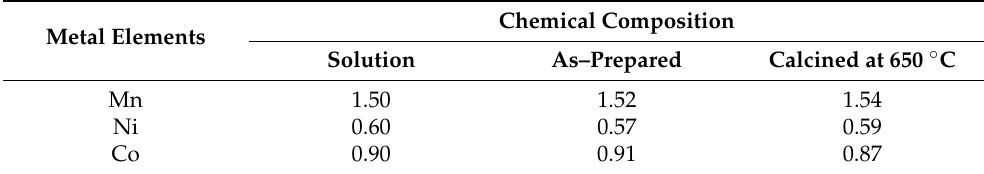
Table 2. Chemical compositions of synthesized powder in different states.